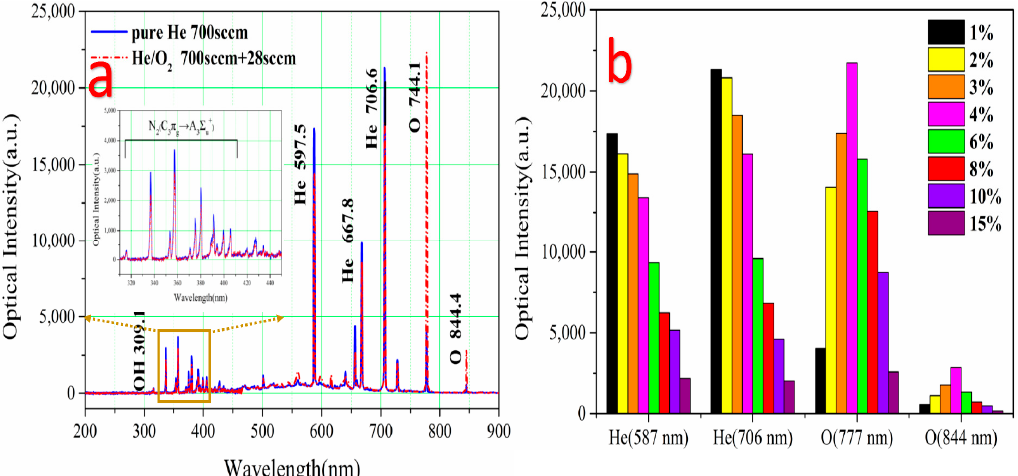
Figure 5. ( a ) Optical emission spectrum (OES) of the plasma microjet from 200 nm to 900 nm measured in the pure helium and helium/oxygen plasma, respectively, the applied voltage was 8.5 kV pp , 11 kHz. The inner picture was the magnified details of OES from 300 nm to 450 nm; ( b ) comparisons of the change of the emission intensities from He (587 nm and 706 nm) and O radicals (777 nm and 844 nm) in different additive oxygen ratio increasing from 0 to 15%.